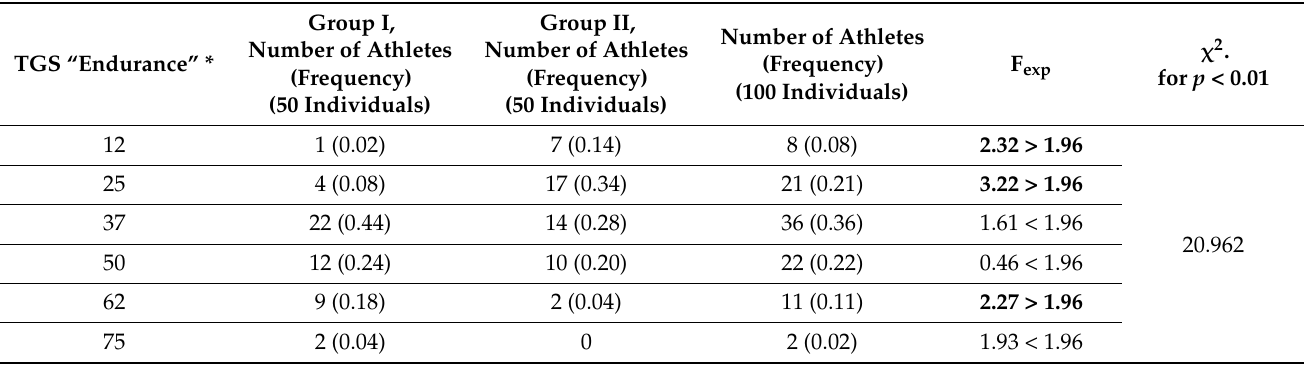
Table 3. The total genetic score of combatants is based on ACE , BDKRB2 , NOS3 , and PPARGC1A gene polymorphisms ( n =